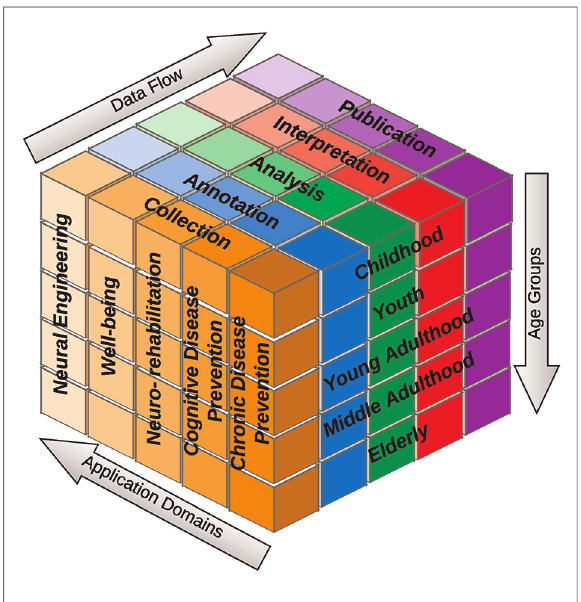
FIGURE 5 “ Cube ” overview: each cube part can be imagined as a box with speci fi c needs, which have to be accounted for and supported by the underlying